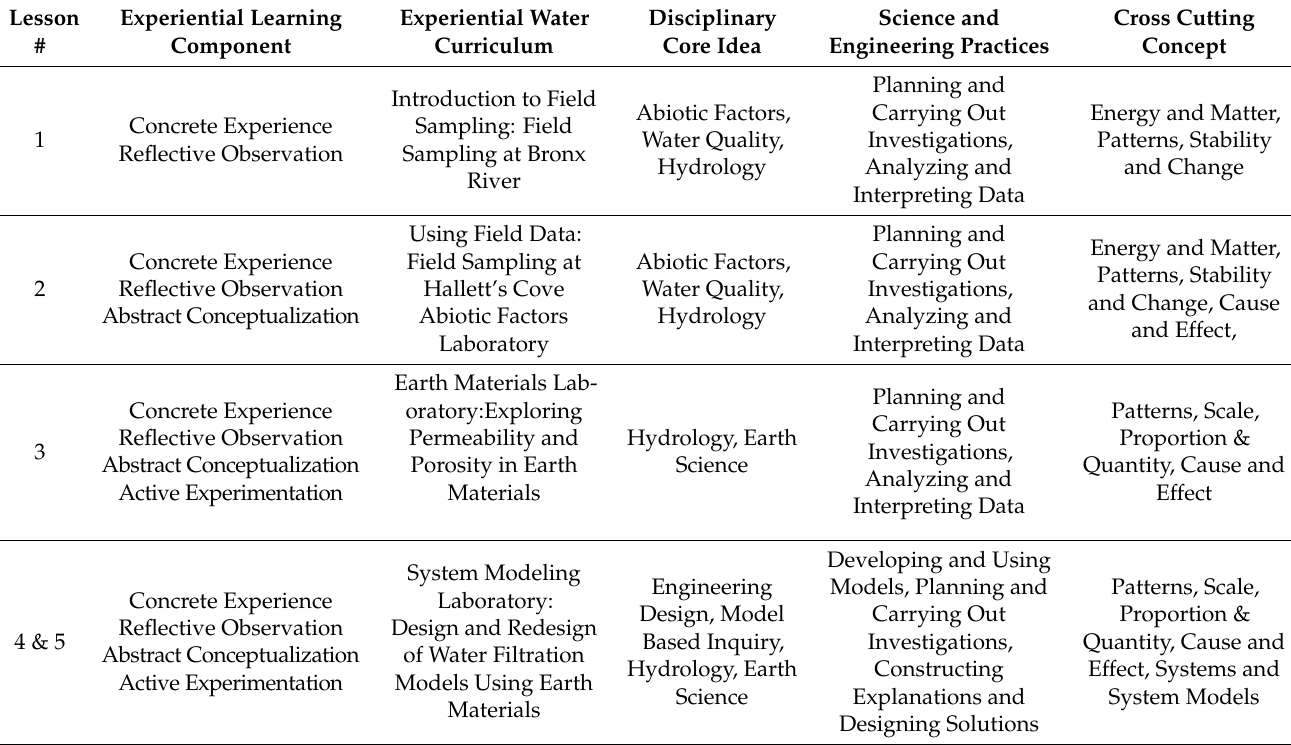
Table 1. Learning Framework for Experiential Water Unit.